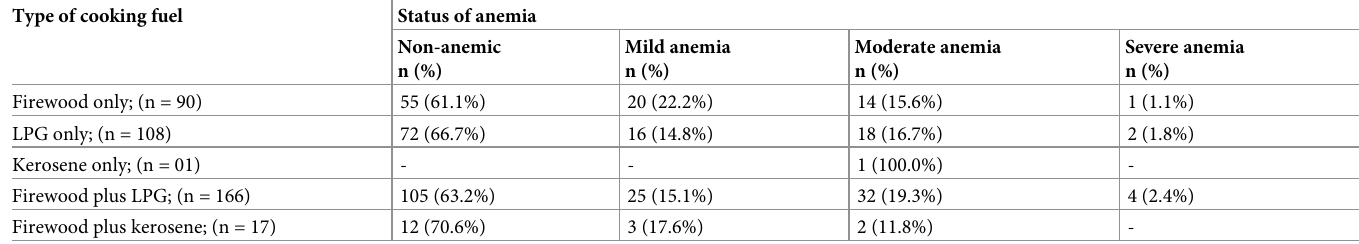
Table 2. Status of anemia based on the type of cooking